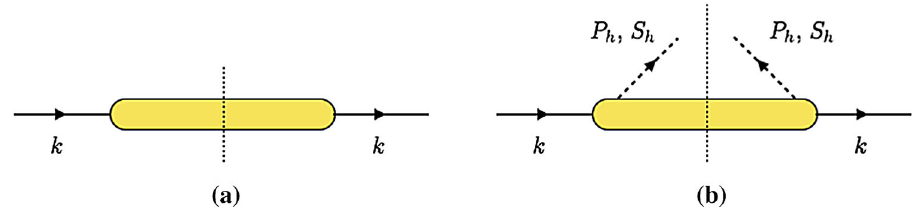
Fig. 1 Diagrammatic interpretations of a the fully inclusive jet corre- lator of Eqs. (1) and (6), and b the single-hadron fragmentation corre- lator (58). The black solid line corresponds to the hadronizing quark with momentum k , the black dashed line to the produced hadron with